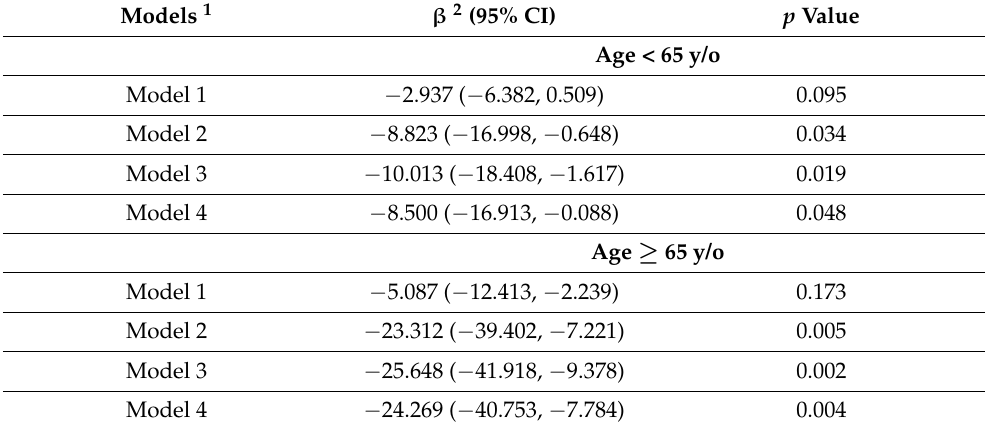
Table 3. Association between serum Klotho concentration and sagittal abdominal diameter with age